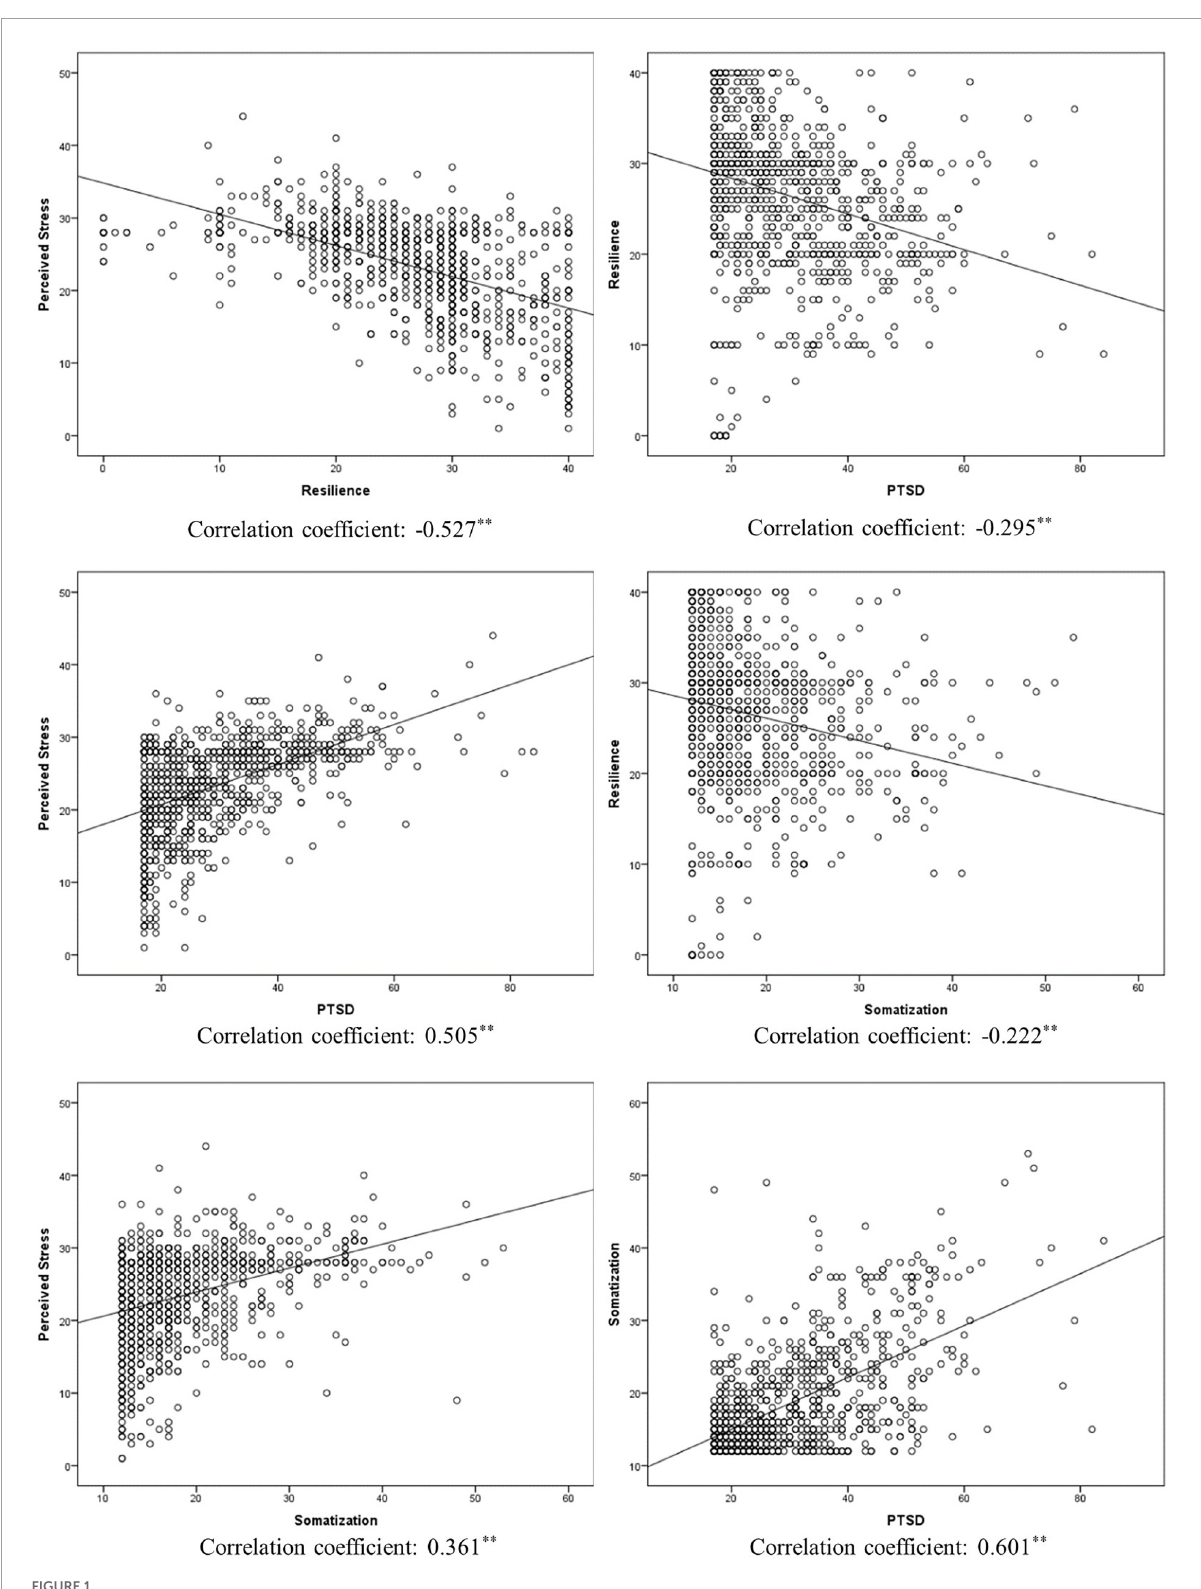
FIGURE1 Scatter plots for study variables ( ∗∗ p <